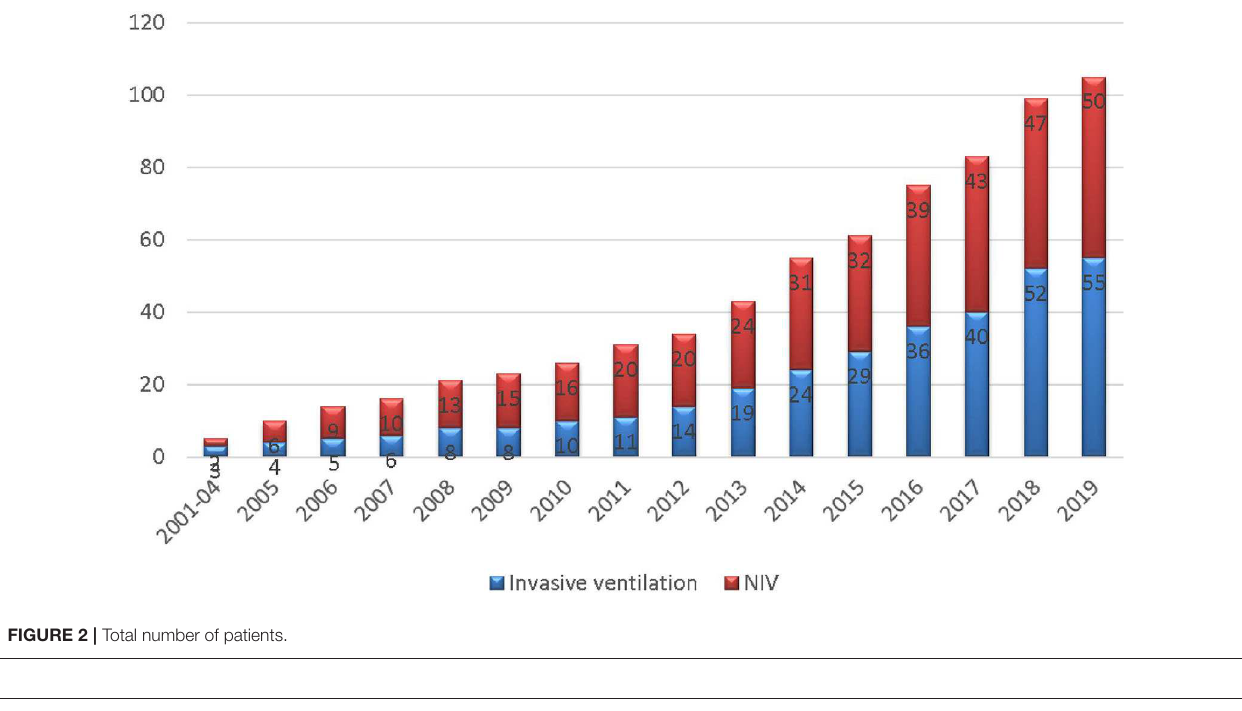
FIGURE 2 | Total number of patients.